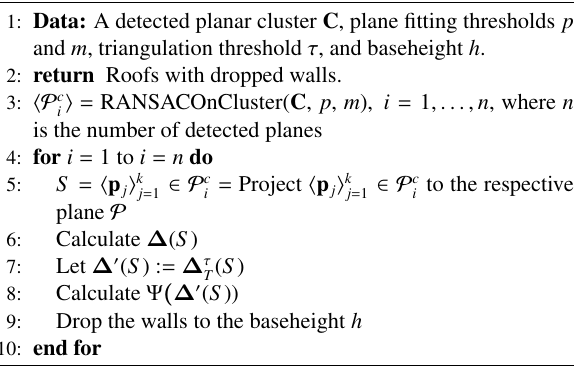
Algorithm 3 Treat Planar Clusters